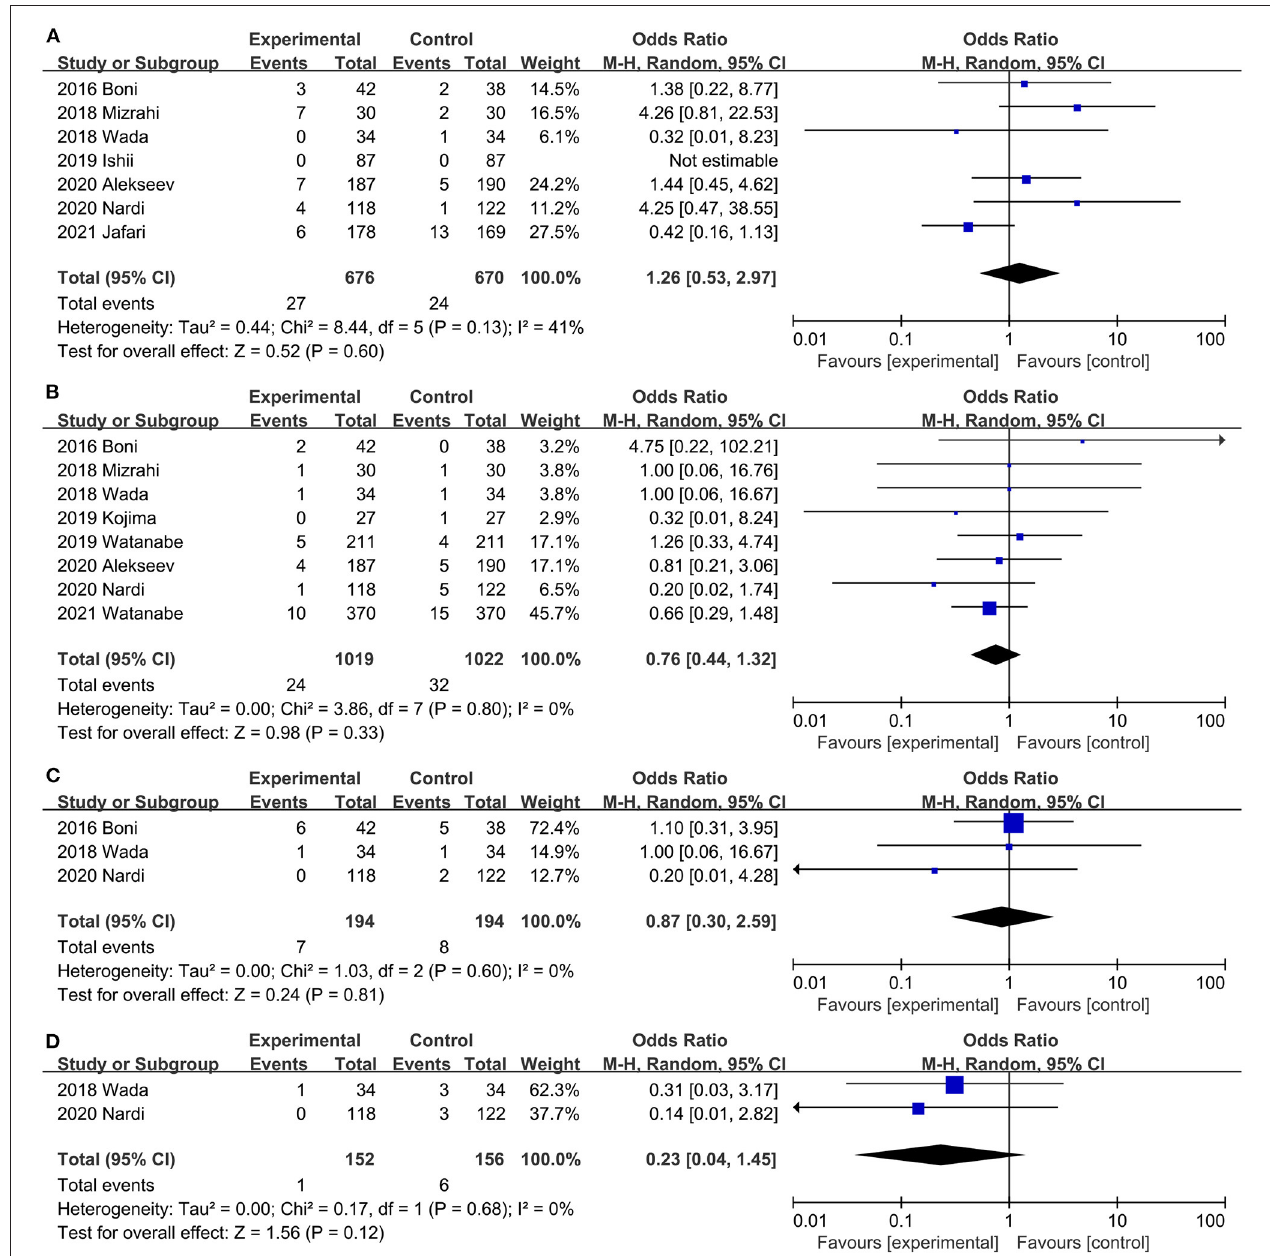
FIGURE 6 | Effect of indocyanine green on (A) Postoperative ileus rate. (B) Wound infection rate (C) Anastomotic stricture rate. (D) Pulmonary infection